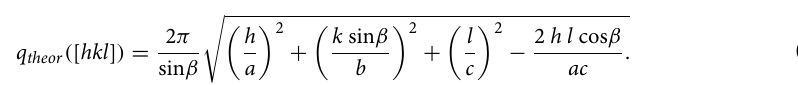
Figure 8. Models used for the approximation of the SAS data. ( A ) Model 1: circular cylinder with a core–shell scattering length density profile (in our calculations, we used ε = 1 for the bicelles). ( B ) Model 2: elliptical cylinder with a core–shell scattering length density